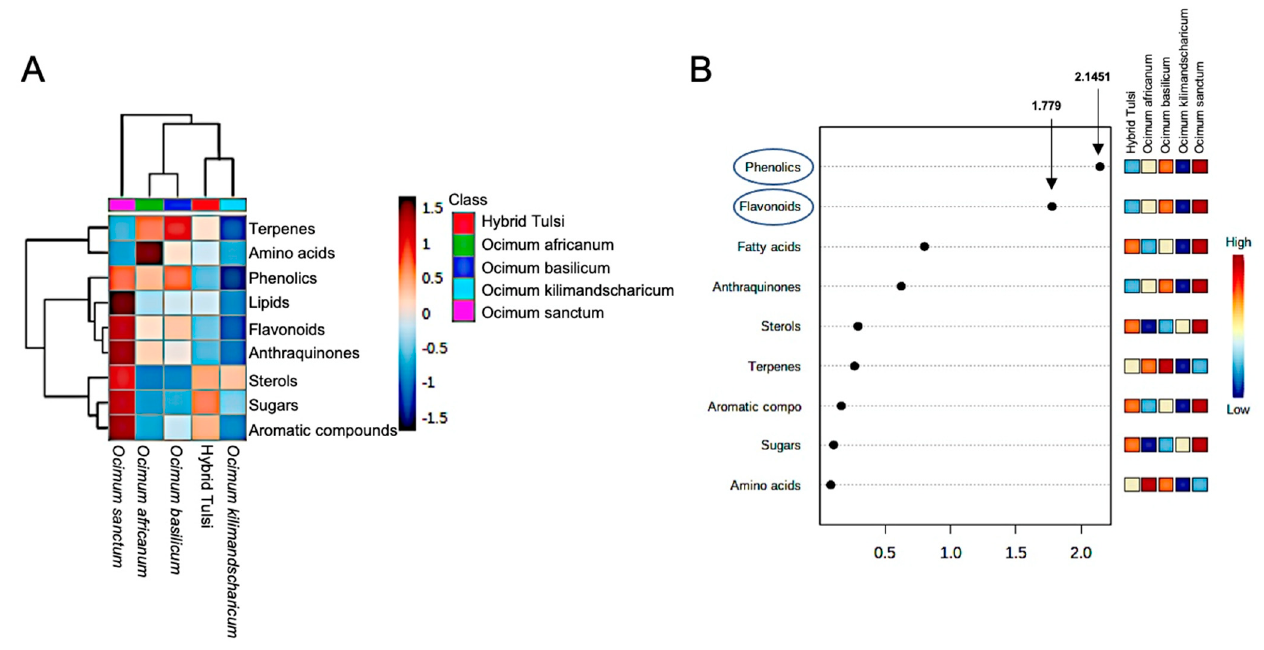
Figure 2. Classification of different metabolite classes in five different Ocimum species samples. ( A ) Quantitative analysis of nine metabolite classes in Ocimum species samples analysed using HCA. ( B ) Variable importance in projection of metabolite classes for the analysed five Ocimum species